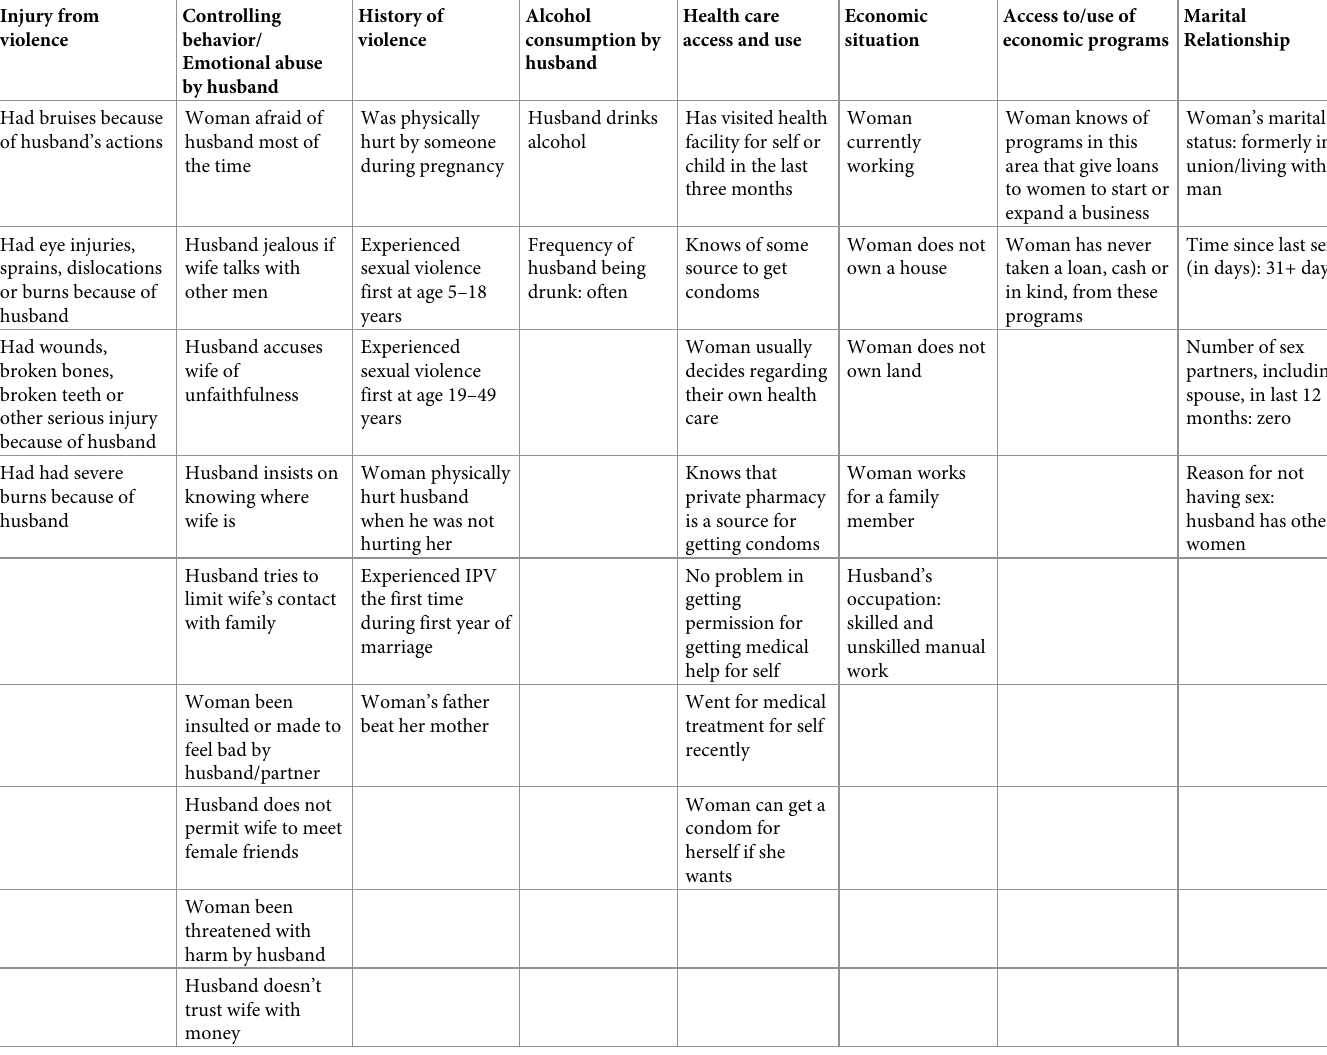
Table 2. Themes and their corresponding variables correlated with IPV help-seeking from anyone, based on iterative thematic analysis (ITA). Injury from